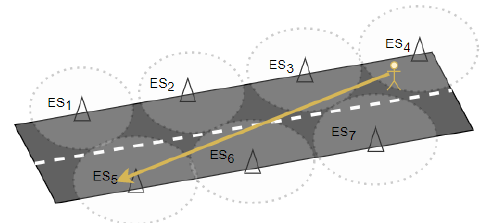
Figure 2. User movement model.